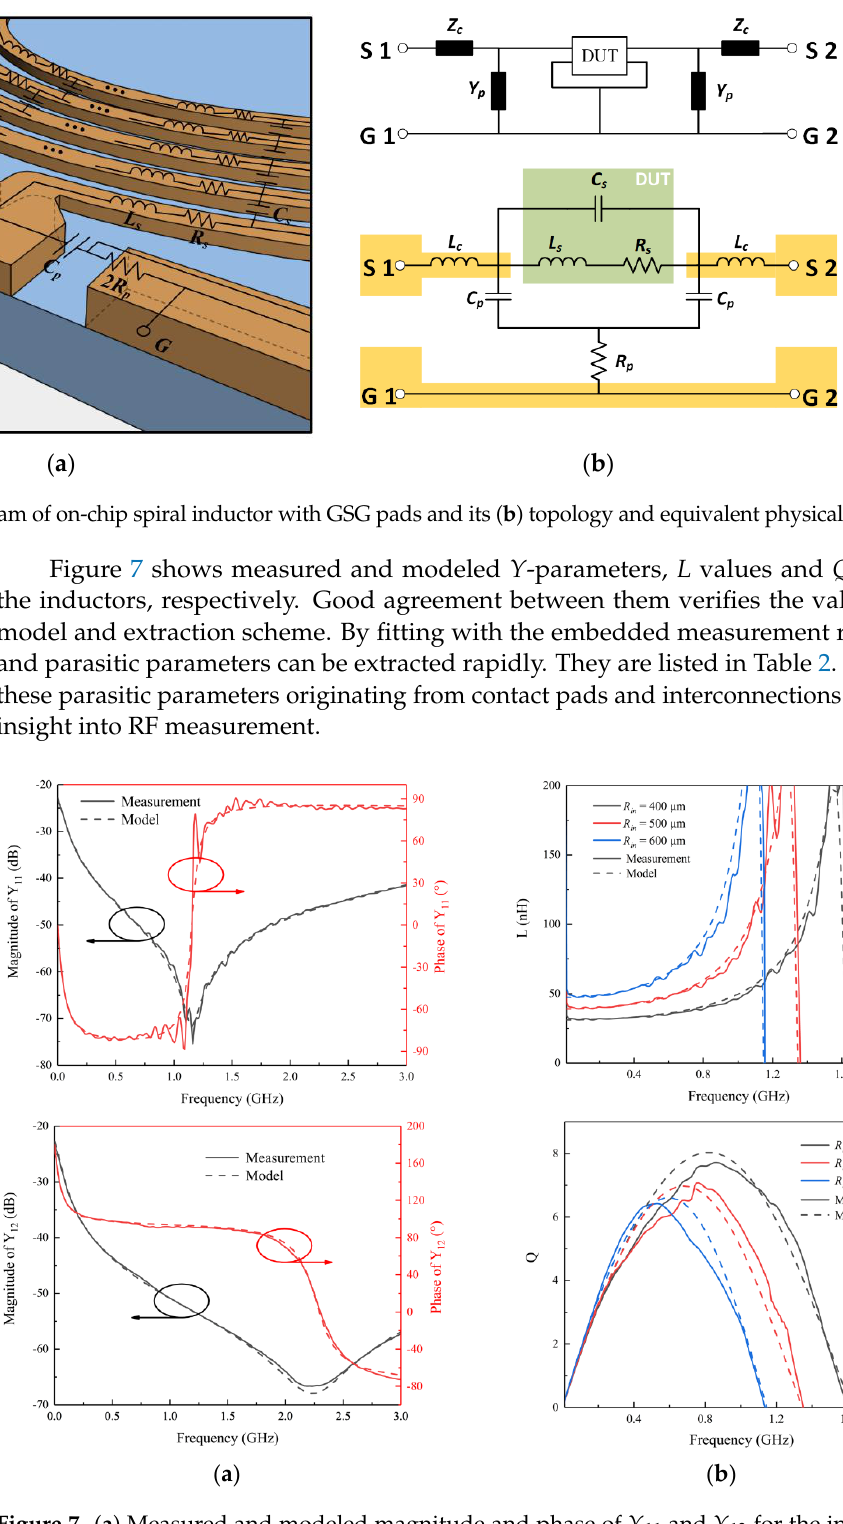
Figure 7. ( a ) Measured and modeled magnitude and phase of Y 11 and Y 12 for the inductors with R in = 600 μm; ( b ) Inductances and Q -factors for the inductors with different R in . Table 2. Summary of model parameters for inductors with different inner radius.